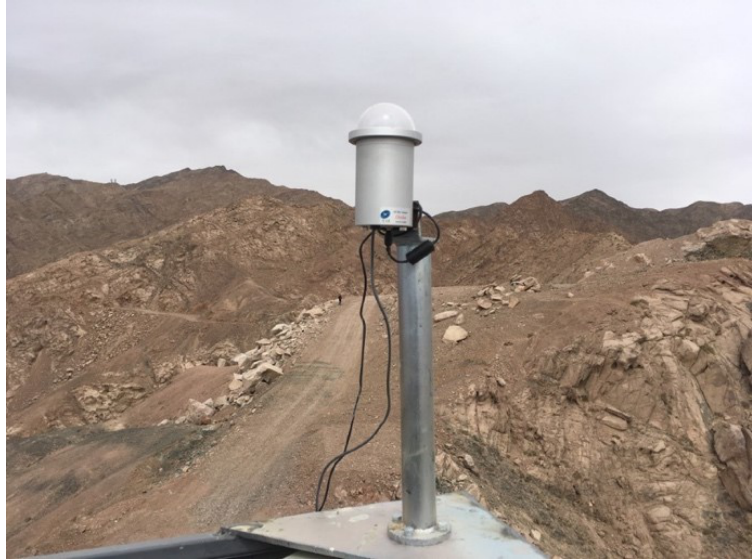
Figure 1. The appearance of the all-sky camera. Table 1. The camera system